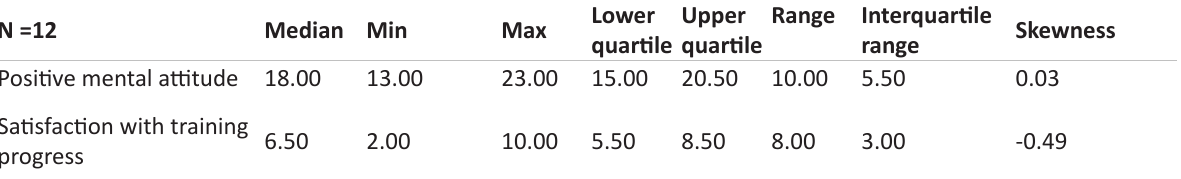
Table 3. Positive attitude and satisfaction with the degree of the growth of one’s fitness as a result of systematic trainings, descriptive